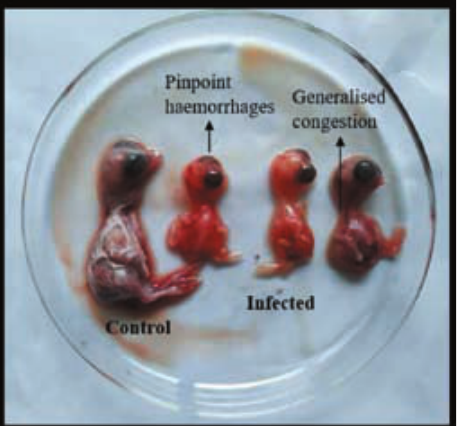
Fig. 3. Characteristic post-inoculation changes of the embryo (9-11 day-old)